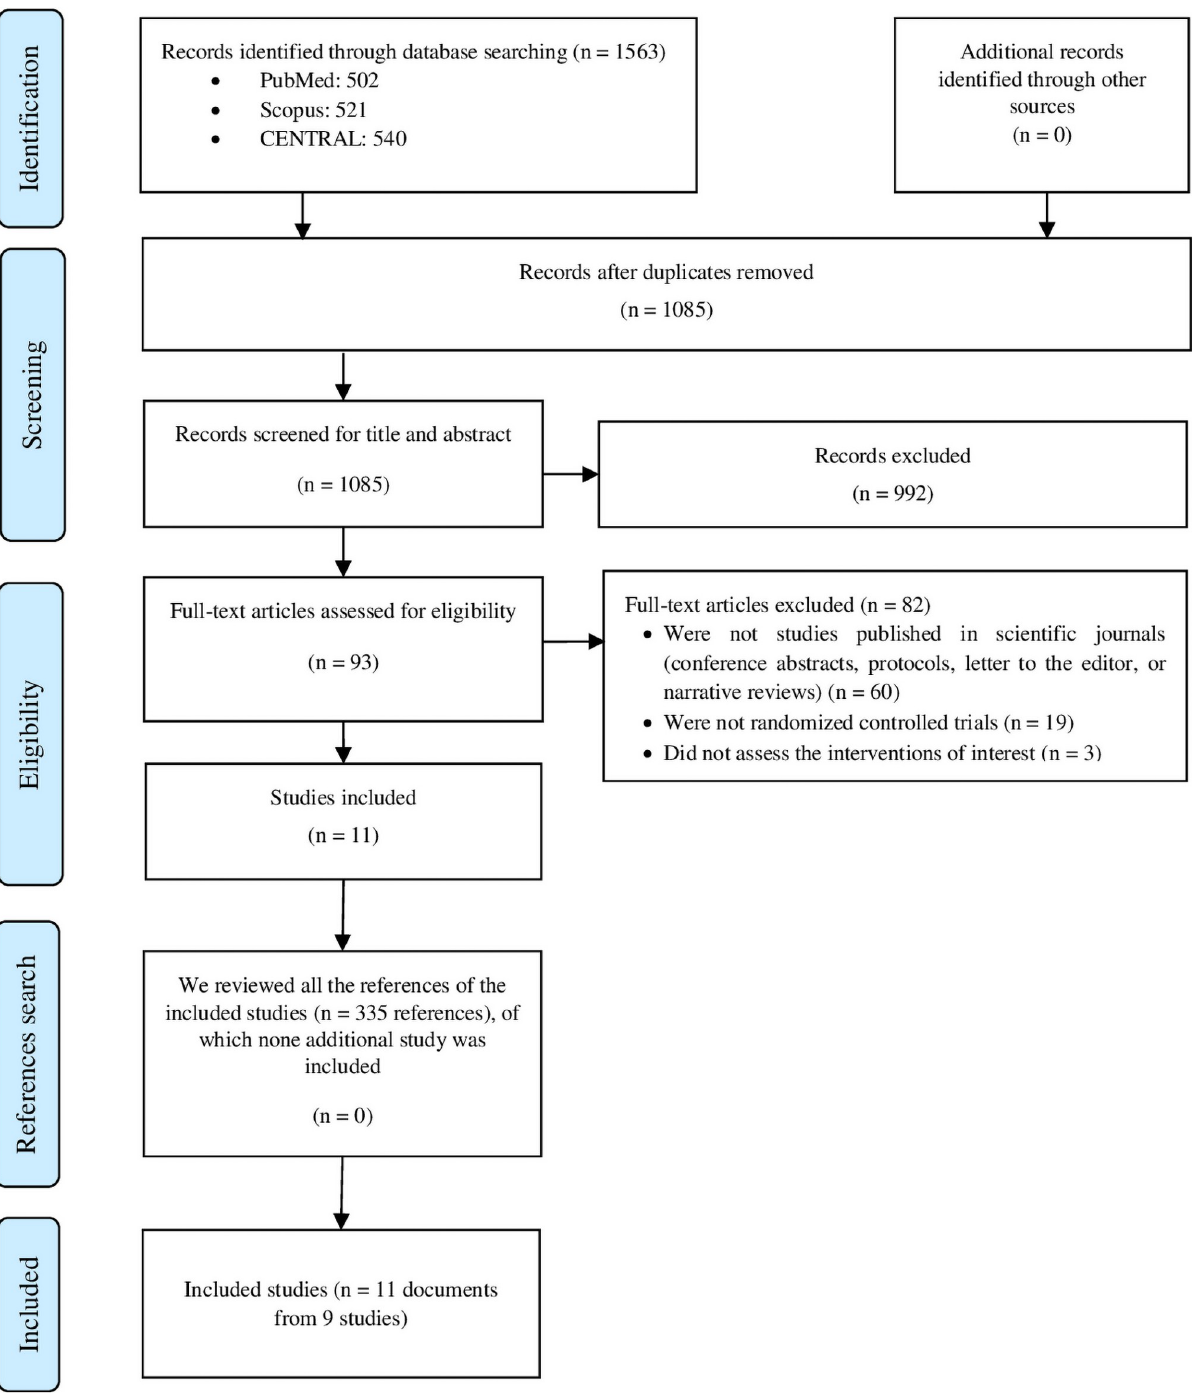
Fig 1. Flow diagram (study selection).